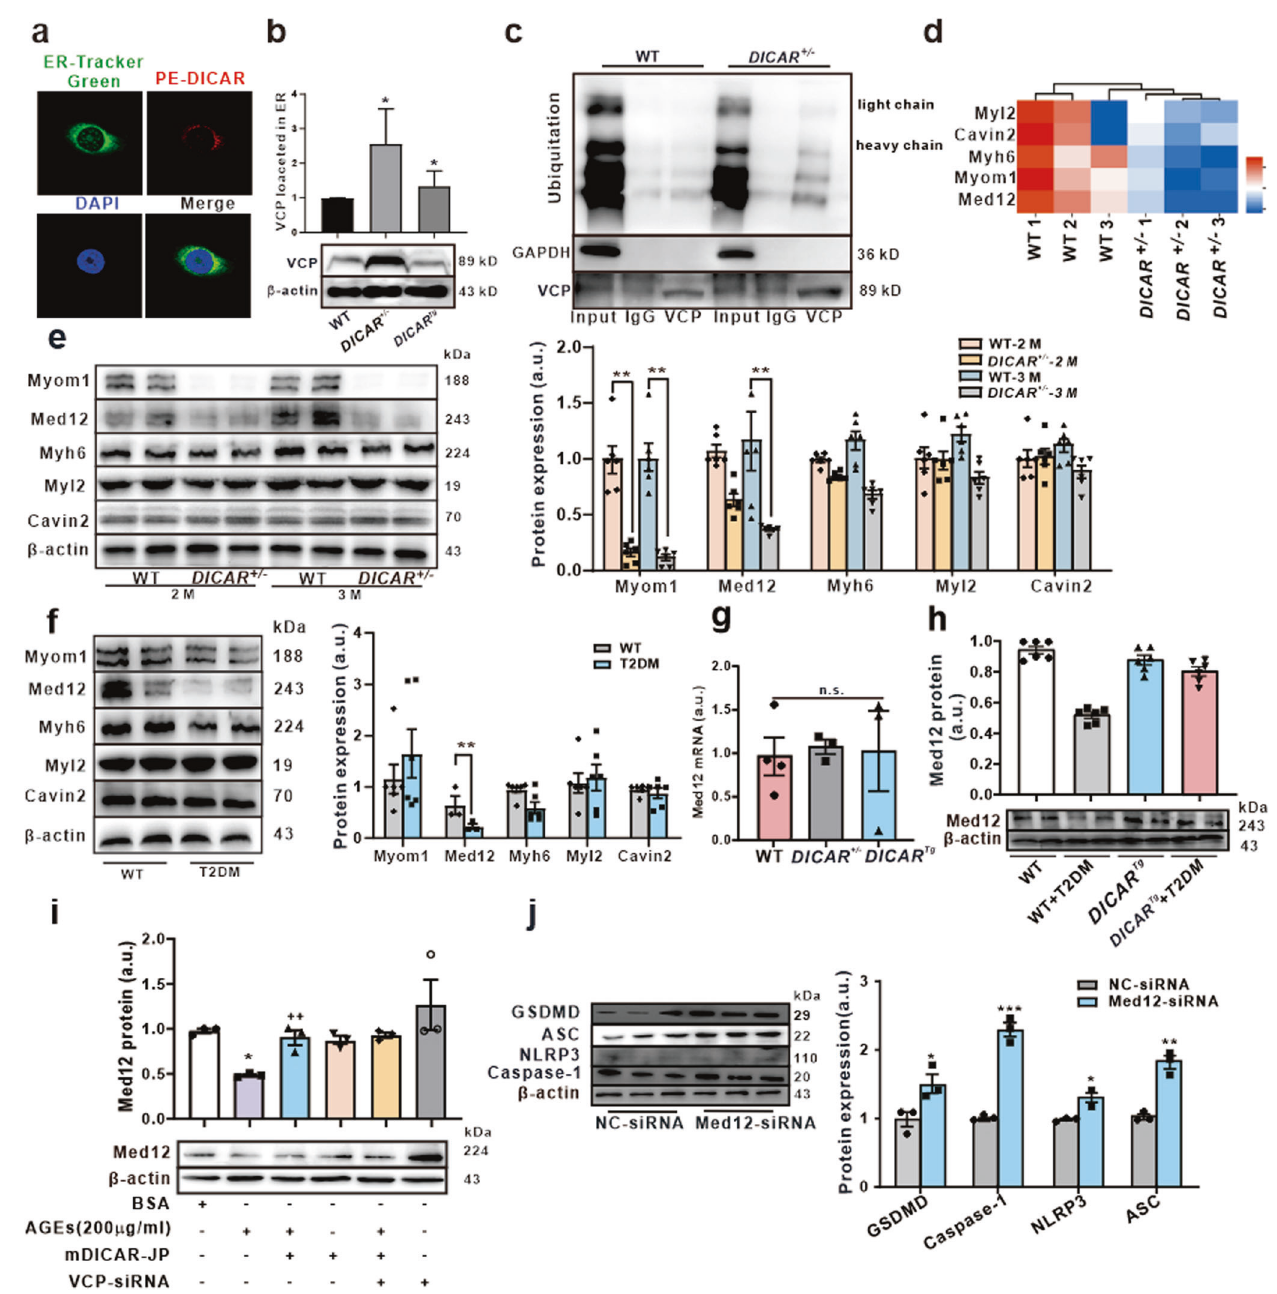
Fig. 5 VCP mediated Med12 protein degradation via the Ub-protein system. a The FISH probe detected DICAR located in the endoplasmic reticulum. b VCP expression in ER, * P < 0.05 vs . WT, n = 3. c Co-IP was used to detect the ubiquitination level of VCP in the heart tissues of DICAR + / − mice. d LC-MS + PRM was used to detect the protein expression in the heart tissues of DICAR + / − mice. e Myom1, Med12, Myh6, Myl2, and Cavin2 protein expression in the heart tissues of DICAR + / − mice detected by WB. f Myom1, Med12, Myh6, Myl2 and Cavin2 protein expression in the heart tissues of db/db mice detected by WB. Data are represented as mean ± SEM. ** P < 0.01 vs . WT, n = 8. g Med12 mRNA in the heart tissues of DICAR + / − and DICARTg detected by qPCR. h Representative images of WB detected pyroptosis of the heart in the DICAR Tg mouse treated by T2DM. Data are represented as mean ± SEM. *** P < 0.001 vs . WT, n = 8. i Representative images of DICAR-JP and VCP siRNA effect on the Med12 protein expression. Data are represented as mean ± SEM. ** P < 0.01 vs . BSA, ++ P < 0.01 vs . AGEs (200 µg/mL, 48 h), n = 3 . j Representative images of Med12 siRNA-induced pyroptosis of HL-1. Data are represented as mean ± SEM. * P < 0.05, *** P < 0.01, *** P < 0.001, vs. NC-siRNA, n = 3 on its biological functions, we named it as DICAR. DICAR has an lethal to mice, which suggests that DICAR is indeed a critical inhibitory effect on the development of DCM, as the spontaneous circRNA at least in mice. cardiac dysfunction, cardiac cell hypertrophy, and cardiac fi brosis occur in heterozygous DICAR de fi ciency ( DICAR + / − ) mice. In contrast, the DCM is alleviated in DICAR-overexpressed DICAR Tg mice. In addition, the homozygous DICAR de fi ciency ( DICAR − / − ) is Signal Transduction and Targeted Therapy (2023)